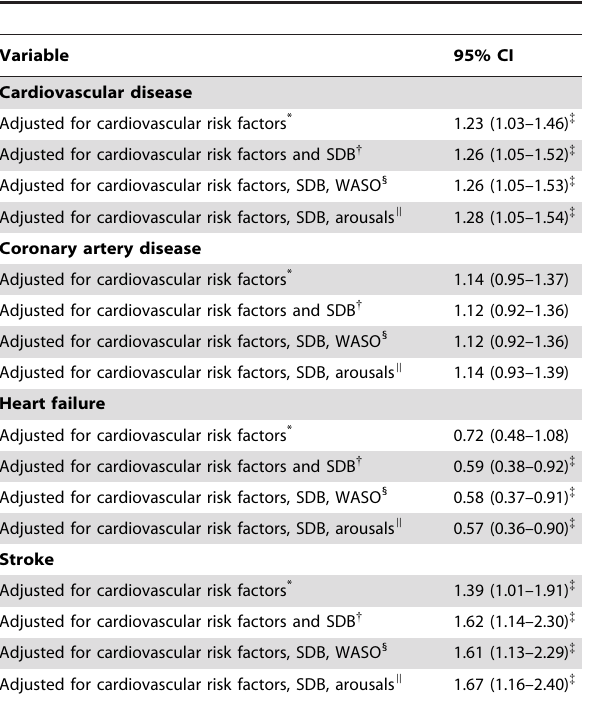
( Table 6 ). Those with nocturia had less total sleep time, sleep efficiency and proportion of REM sleep, but had a higher arousal index and were more hypoxemic. They also were subjectively more sleepy on the basis of their Epworth Sleepiness Score.